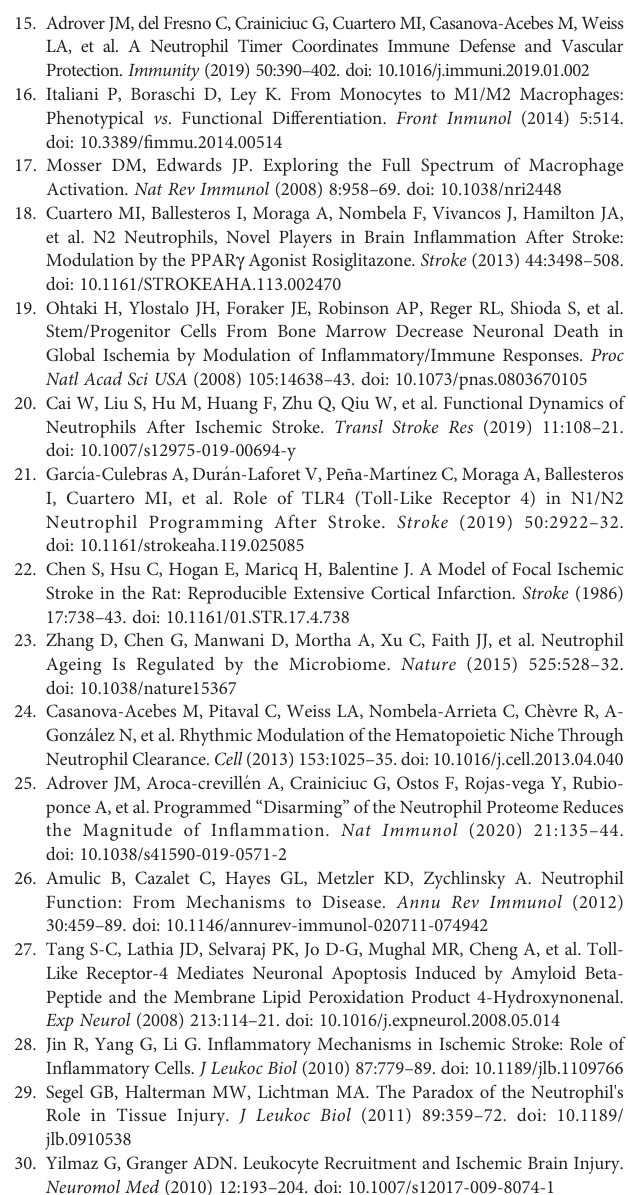
Supplementary Figure 4 | Analysis of neutrophil phagocytic activity. Two-way ANOVA analysis showed a signi fi cant effect of the time variable and the Bonferroni post-hocshowedadecreaseinthephagocyticactivityofneutrophilsfromTLR4 loxP/ Lyz-cre mice (*P < 0.05, F[2, 19]=12.92; n=4-5). Supplementary Figure 5 | NETosis in the absence of TLR4. Percentage of NET- like events (H3Cit + /Elastase + ) (n=4-6). Supplementary Figure 6 | ROS production by neutrophils in the absence of TLR4. (A) Post-ischemic analysis of ROS production (24 and 48 h after the stroke). (B) Two-way ANOVA analysis of the data showing a signi fi cative effect of time in both genotypes (P<0.05) and a signi fi cative difference between activated neutrophils of both genotypes at pre-surgery time point (*P < 0.05, F (1.028, 13.87) = 6.063;